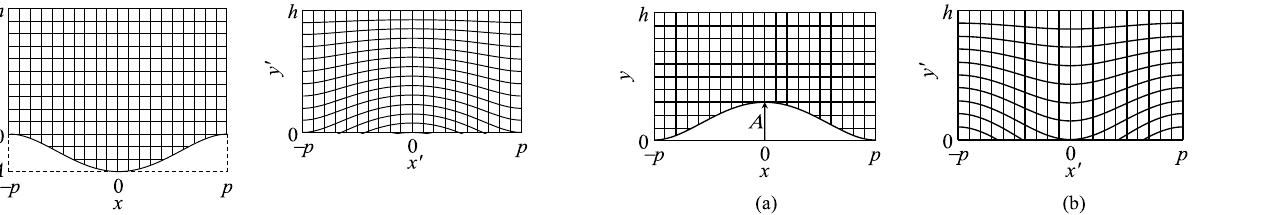
Fig. 6. Coordinate transformation for the bump illusion medium. (a)OriginalCartesiancoordinatesystem( x , y ).(b)Transformednon- conformal coordinate system ( x 0 , y 0 ).